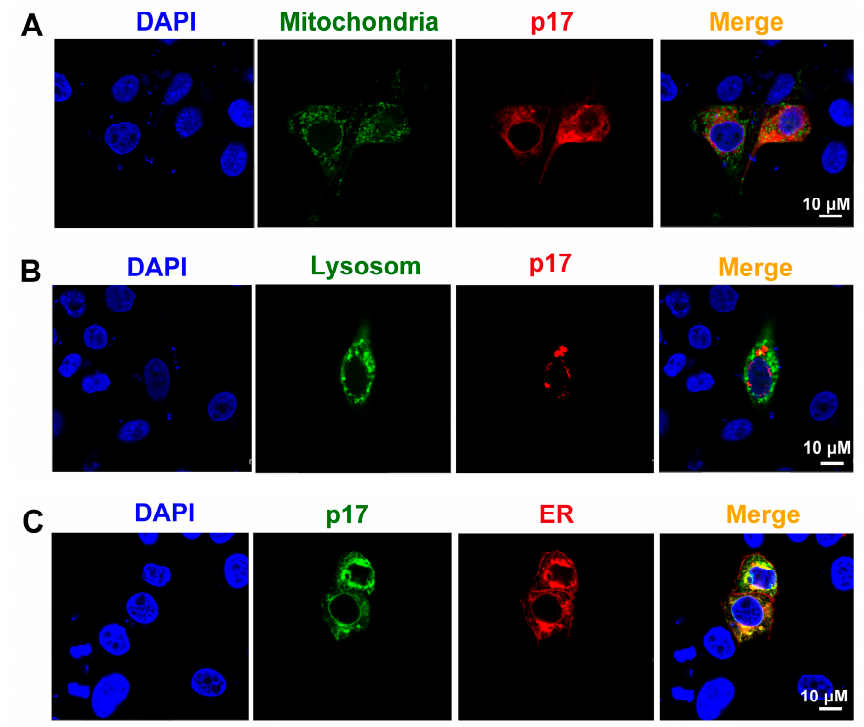
Figure 4. The subcellular localization of p17 protein in PAM cells was determined by confocal microscopy; p17 protein was co-localized with the ER marker, but not with mitochondrion and lysosome markers. ( A ) Plasmids of dsRed-p17 and Mito-EGFP (mitochondrial targeting sequence of cytochrome c oxidase subunit VII fused to EGFP) were co-transfected into PAM cells. ( B ) Plasmids of dsRed-p17 and GFP-LAMP1 (lysosomal-associated membrane protein1) were co-transfected into PAM cells. ( C ) Plasmids of FLAG-p17 and RFP-KDEL (an ER retention protein) were co-transfected into PAM cells.